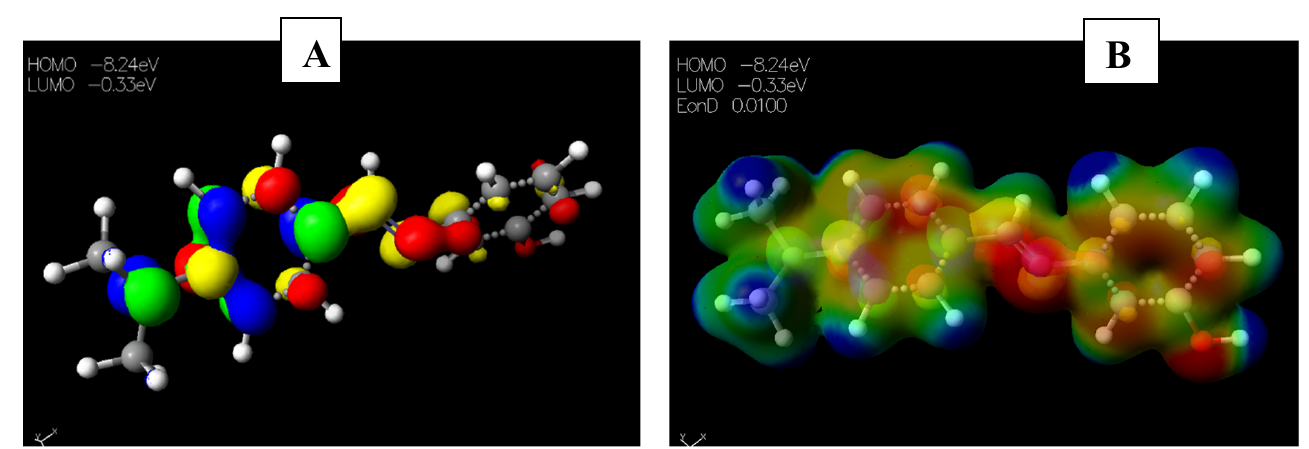
Figure 5. Images showing the ( A ) Highest occupied molecular orbital (HOMO) and Lowest unoc- cupied molecular orbital (LUMO) and ( B ) Molecular electrostatic potential (MESP) plots of 1.